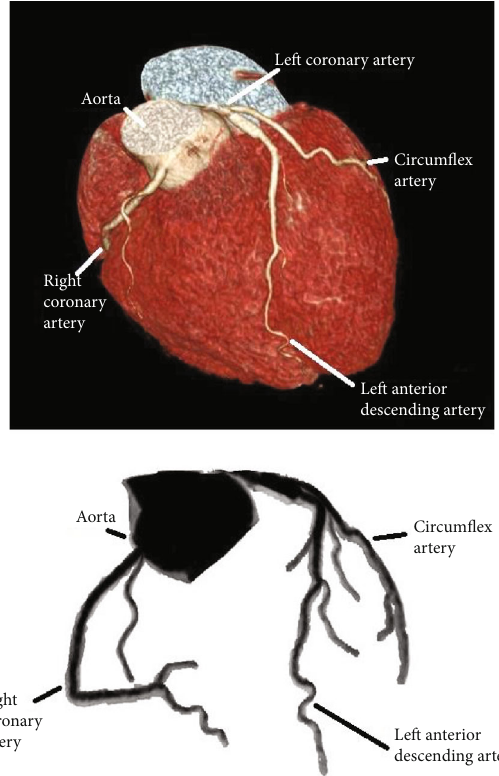
Figure 4: MSCT coronary angiography showed no signs of stenosis and no variations in coronary